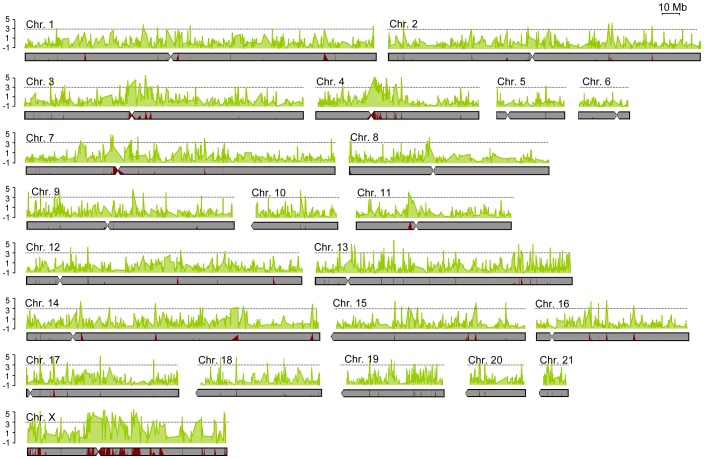
Levels of differentiation between subspecies varied greatly across the genome.Chromosomal distribution of genetic differentiation for all rabbit chromosomes. Each data point is based on a sliding window analysis using 100 kb windows with 10 kb steps. The solid black line denotes a Z-score of three (three standard deviations departing from the median FST over all windows). The relative proportion of fixed (red) versus shared (gray) polymorphism for each window is indicated below the graph (F/S).